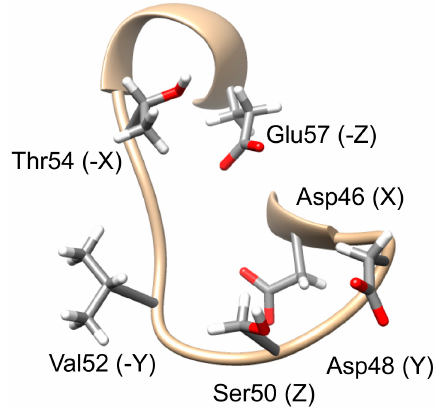
Figure 6. EF-hand calcium-binding site. The Ca 2+ -binding site of CsTegu20.6 was predicted from that of Rattus norvegicus (PDB ID: 1XVJ_A). The consensus binding residues are Asp46, Asp48, Ser50, Val52, Thr54 and Glu57, and the labels are indicated in parentheses. Side-chain oxygen and hydrogen atoms were colored in red and white, respectively.